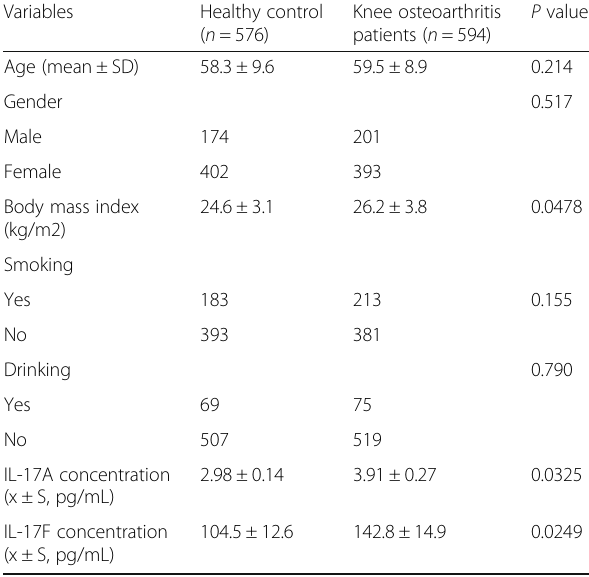
Table 1 Demographic characteristics of the study population